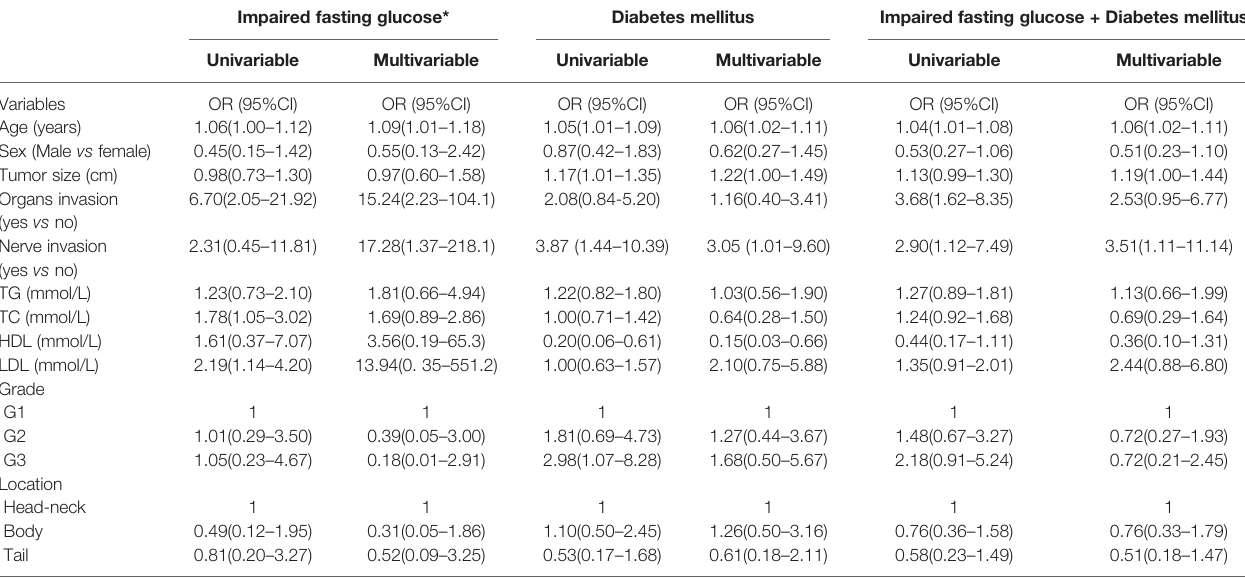
TC, Serum total cholesterol; TG, serum triglyceride; HDL, high-density lipoprotein; LDL, low-density lipoprotein. Multivariable regression analysis was additionally adjusted with vascular and lymph node invasion. *Patients with diabetes mellitus were not